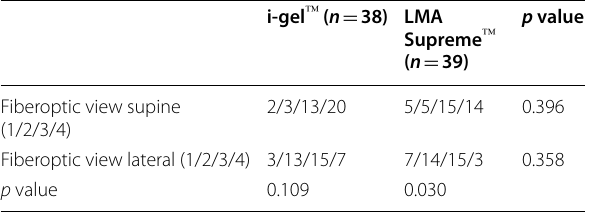
Table 5 Fiberoptic views with both